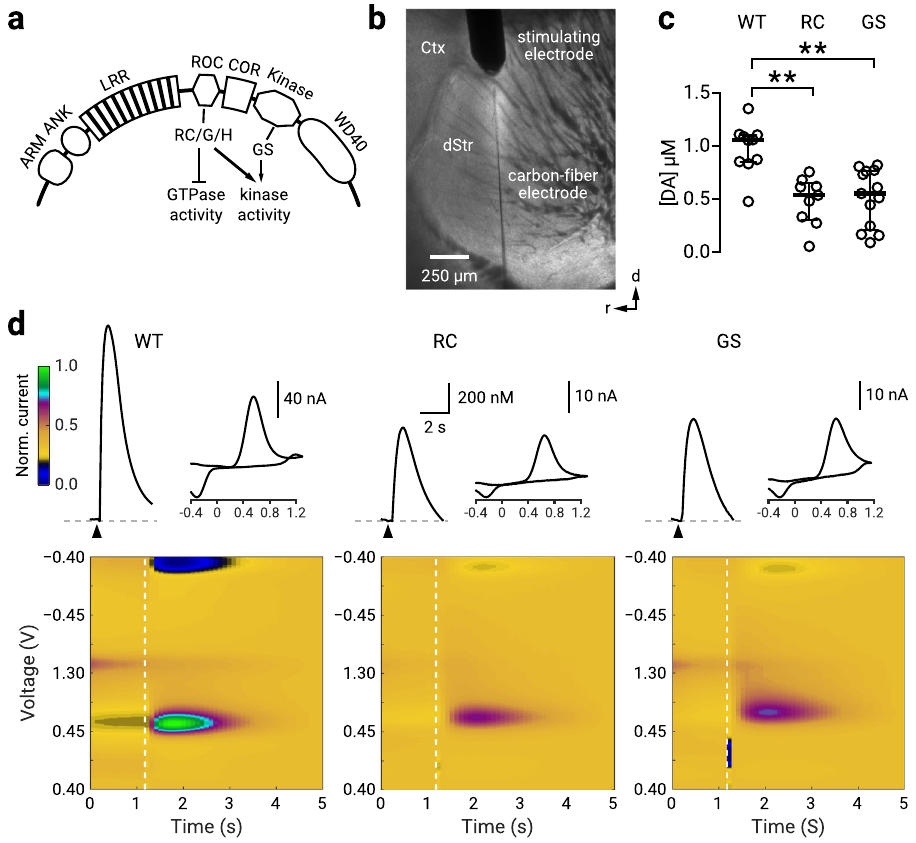
Fig. 1 RC and GS LRRK2 mice have decreased nigrostriatal dopamine release. a A schematic diagram of LRRK2 protein: a family of Ras-like G-proteins with functionally distinct multi-domains, consisting of armadillo repeats (ARM), ankyrin repeats (ANK), the leucine-rich repeats (LRR), the C-terminal of Roc (COR), the ROC GTPase domain where the R1441C/G/H (RC) mutations reside, and the kinase domain where the G2019S (GS) mutation resides. The WD40 domain is involved in membrane binding with ARM and ANK believed to stabilize the electrostatic surfaces of the domains. b . Bright fi eld photomicrograph of a parasagittal slice with a concentric stimulating electrode placed in the dorsal striatum (dStr); a carbon fi ber electrode was inserted adjacent to the stimulation site. Ctx, cortex. c Population data showing for evoked [DA] in WT, RC, and GS LRRK2 KI mice. The median evoked concentrations were: [DA] WT = 1057.6 ± 117.9 nM ( n = 10); [DA] RC = 538.7 ± 143.2 nM ( n = 9); [DA] GS = 554.9 ± 218.4 nM ( n = 13). Compared to